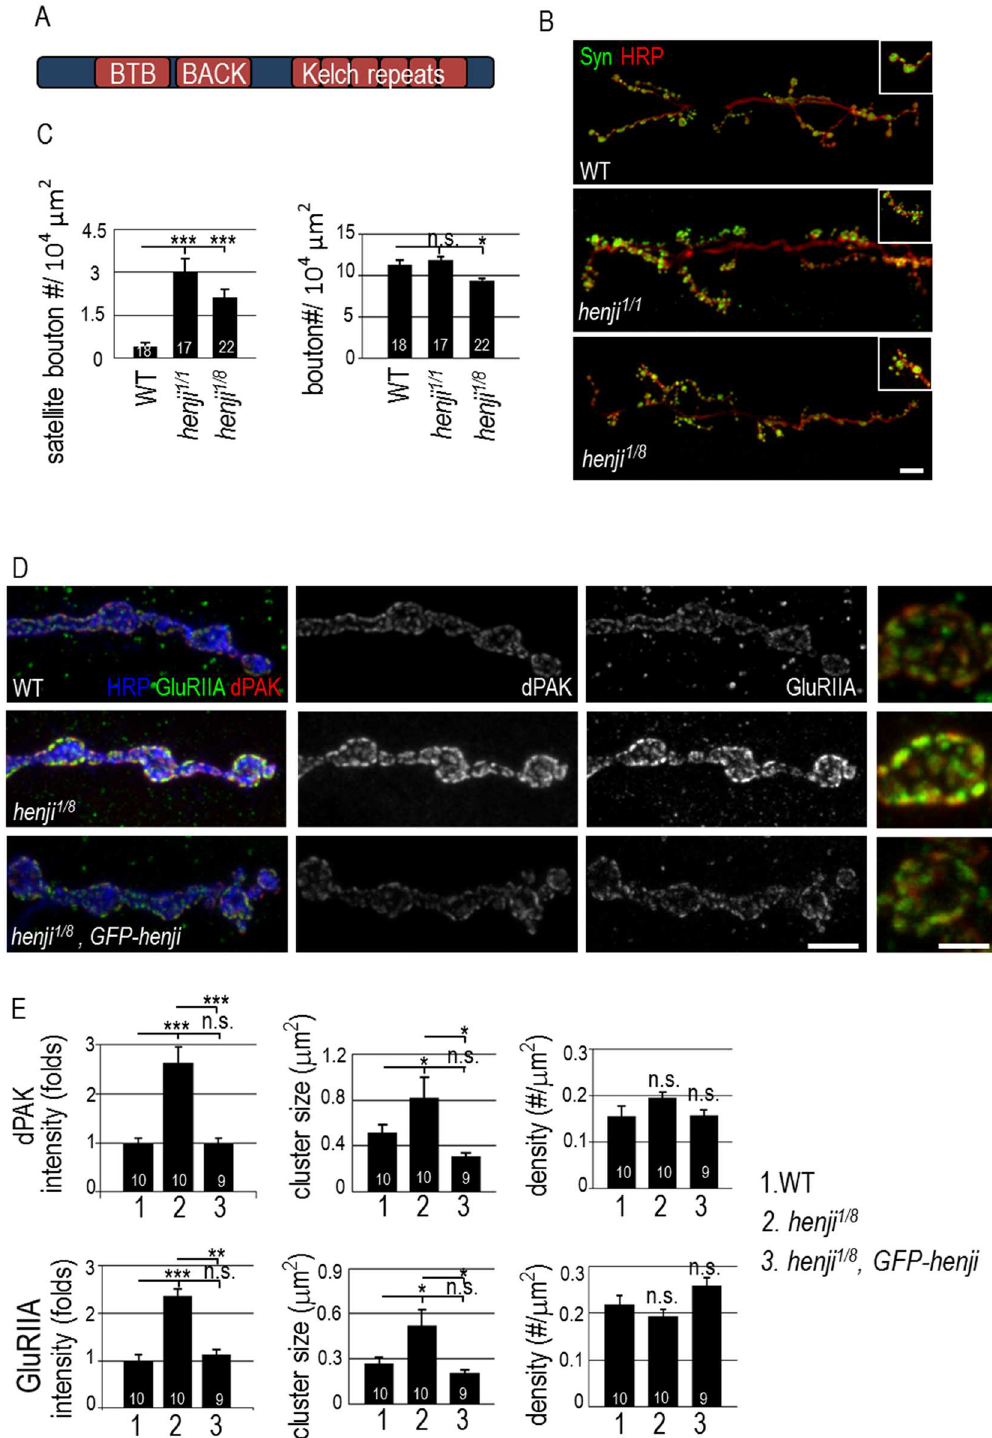
Fig 1. NMJ morphology and dPAK and GluR levels are altered in henji mutants. Schematic diagramshows the conserved BTB, BACK and Kelch repeats domains of Henji. (B) Immunostaining of third-instar larval NMJs of w 1118 (WT), henji 1 /henji 1 ( henji 1/1 ) and henji 1 /henji 8 ( henji 1/8 ) with anti-HRP and anti-Synapsin (Syn) antibodiesto reveal the overall NMJ morphology. Insets show enlarged images of normal and satellite boutons in each panel. Scale bar represents 20 μ m. (C) Bar graphs show mean numbers ( ± SEM) for satellite boutons normalizedto